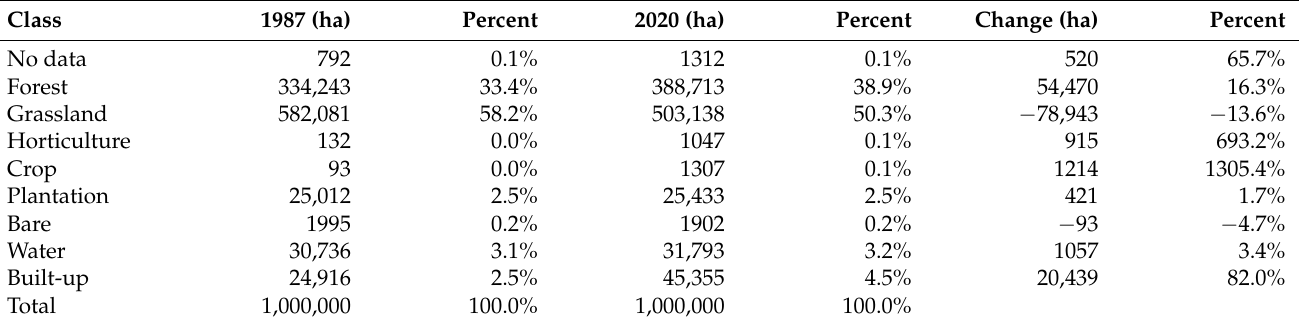
Table 5. Extent of predicted land cover classes for 1987 and 2020 showing changes.